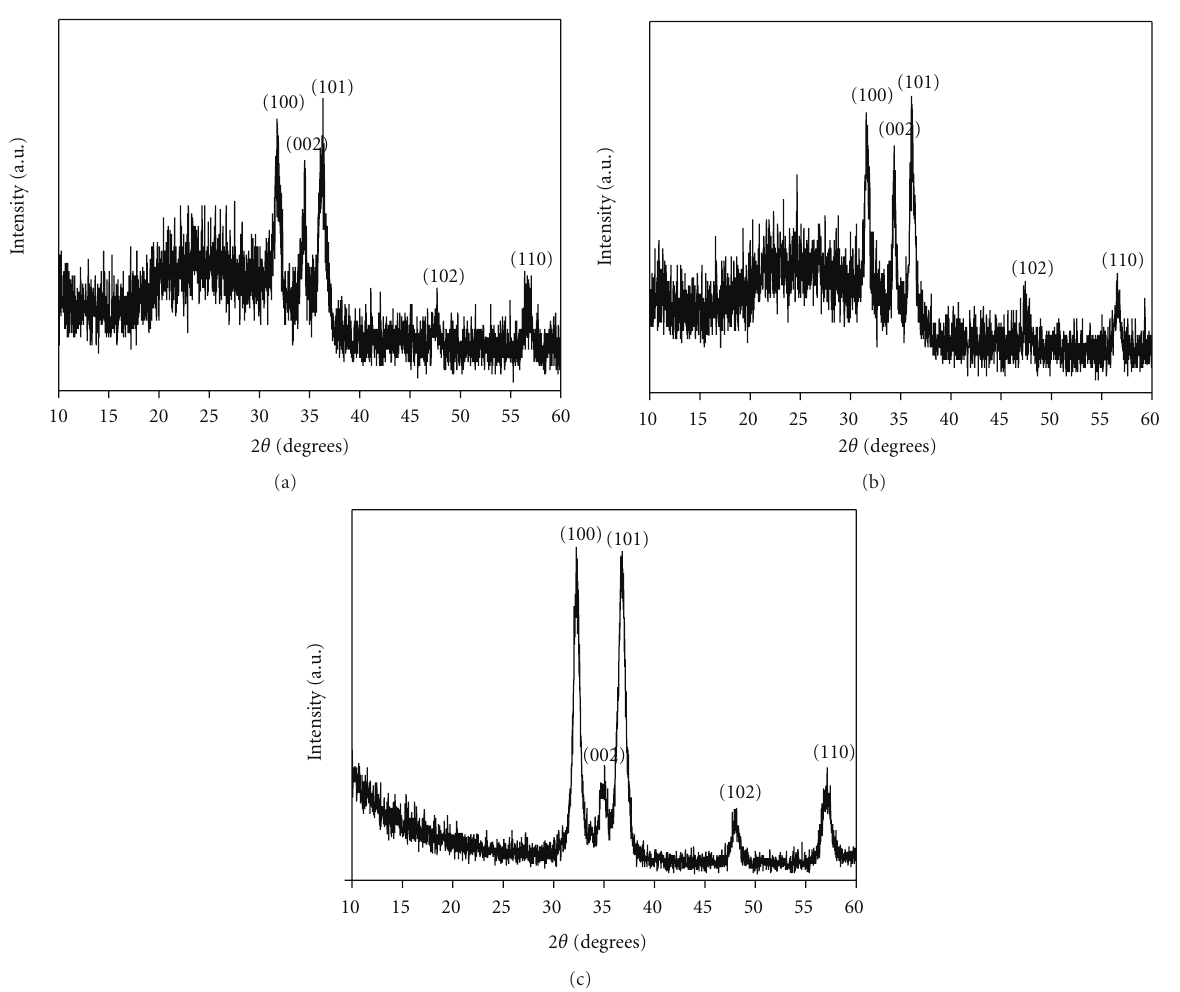
Figure 8: XRD patterns of sample A (a), sample B (b), and sample C (c).